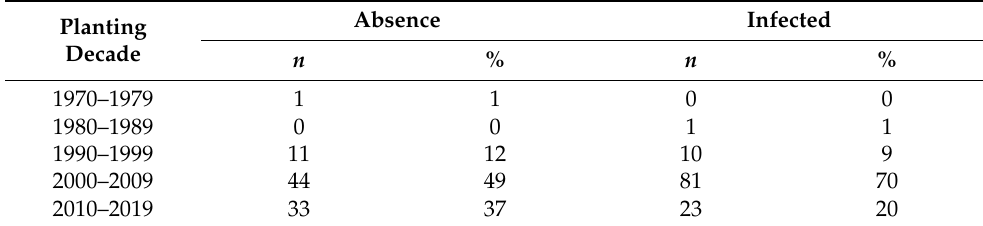
Table 5. Temporal distribution of planting events in buffer zones comparing absence (41 monads, 89 events) and infected (25 monads, 115 events) locations as number ( n ) and percentage (%) of records per category per decade.